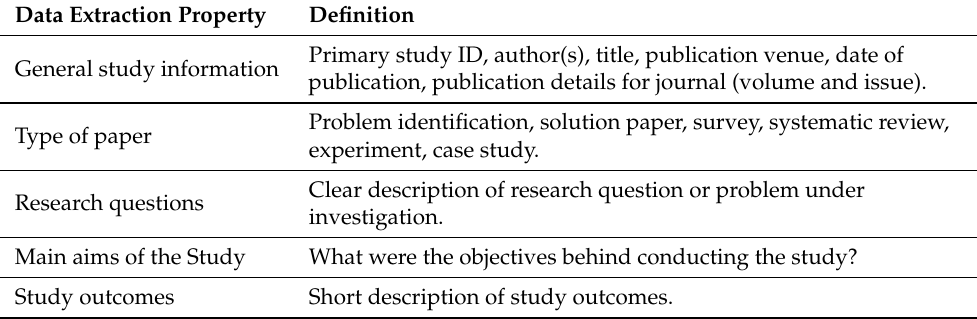
Table 3. Data extraction